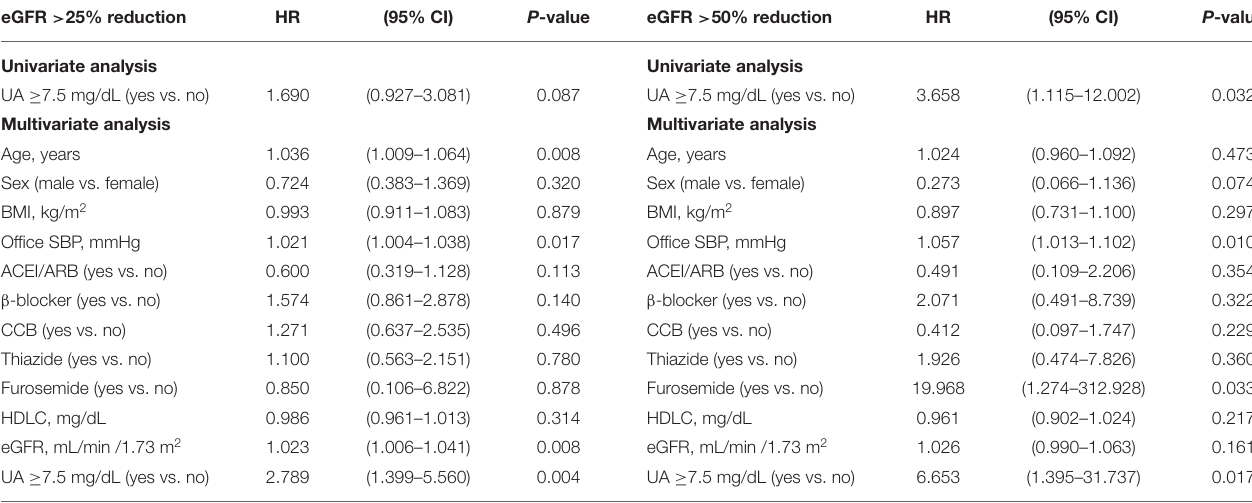
TABLE 7 | Uric acid 7.5 mg/dL and decline of estimated glomerular filtration rate (eGFR). eGFR > 25% reduction